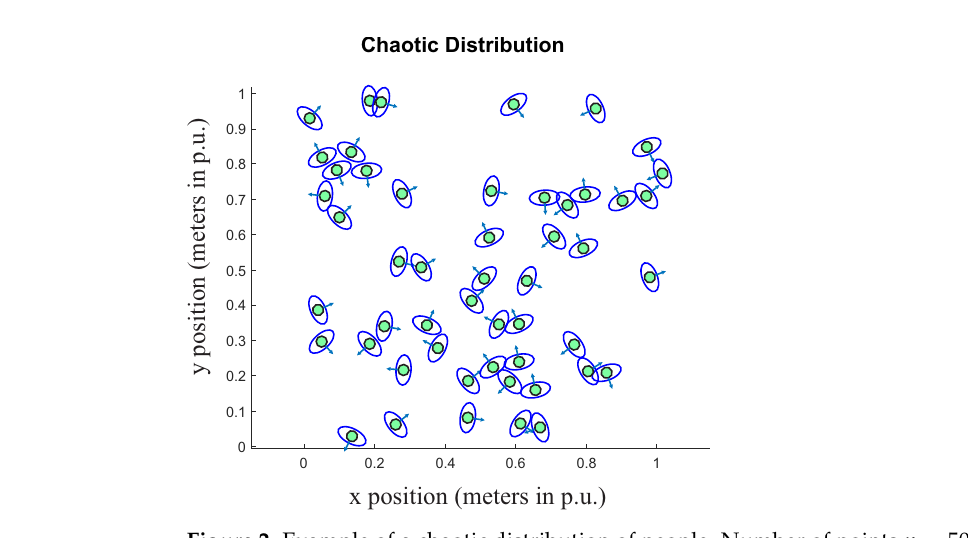
Figure 2. Example of a chaotic distribution of people. Number of points n =